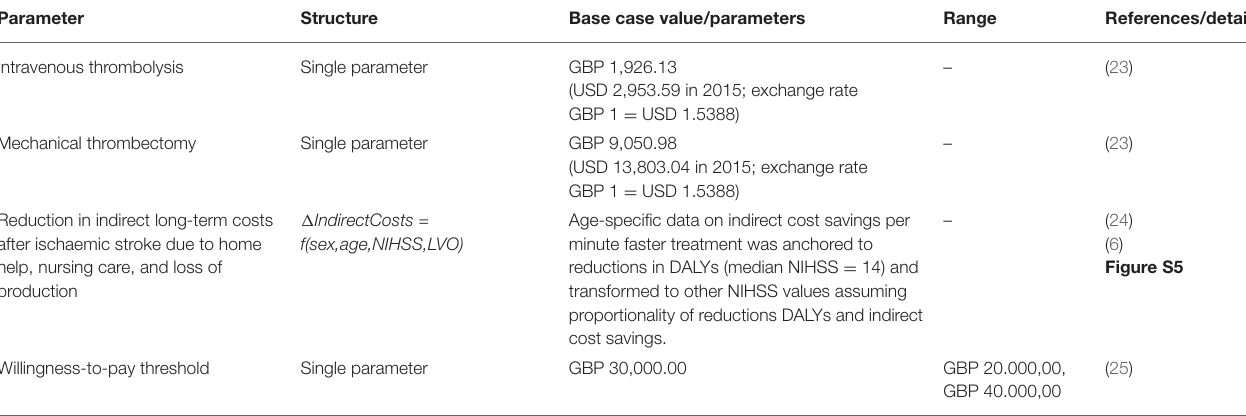
TABLE 5 | Cost parameters used in the model.